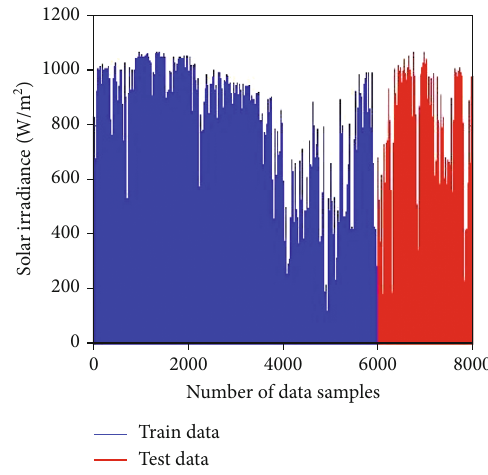
Figure 6: Data samples of the solar radiation trained and tested